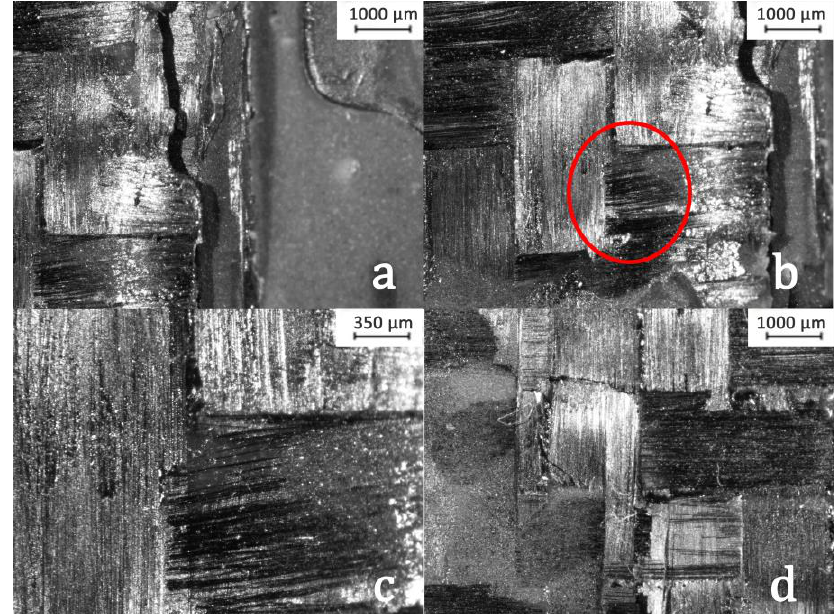
Figure 7. Fractographic analysis of JLS specimens. ( a ) Peeling at the knee of adhesive; ( b ) Debonding of laminates; ( c ) Ruptured Fiber; ( d ) Fiber / Matric